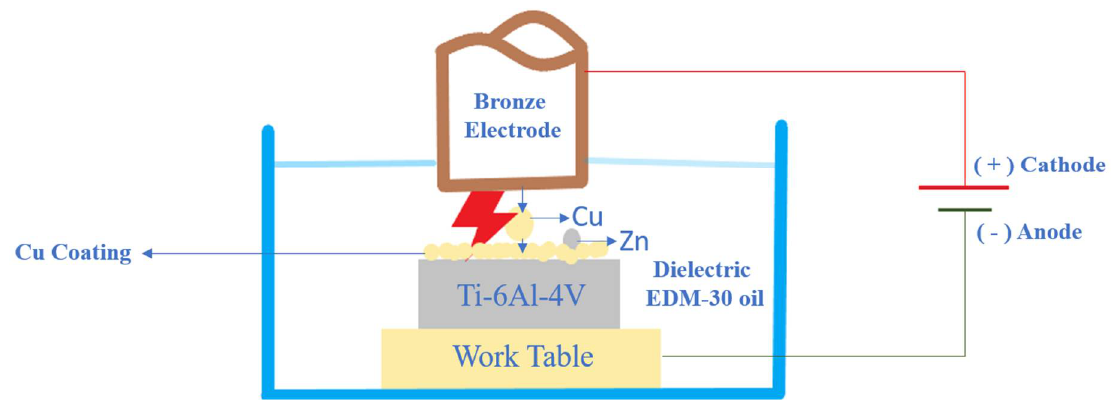
Figure 2. Working principle of EDC .